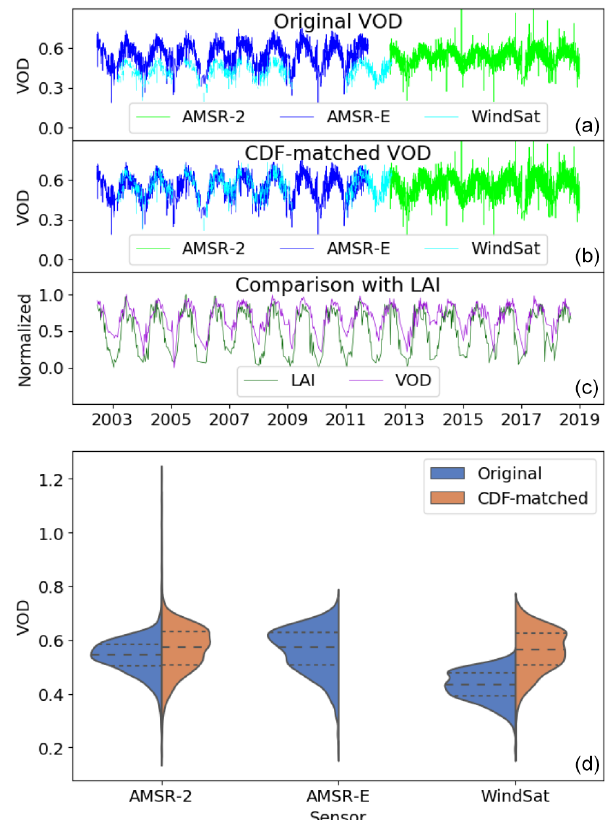
Figure 3. (a–c) Example X-band time series for a grid cell in Aus- tria (15.125 ◦ E, 48.125 ◦ N, mostly farmland with about 20% forest) at different processing steps. Time series of the original VOD data of all available sensors are shown in (a) , the CDF-matched series in (b) , and the final merged VOD (VODCA) together with MODIS LAI in (c) . In (c) VOD and LAI are both normalized, and VOD is downsampled by moving average to match the temporal 8d resolu- tion of LAI. (d) Violin plot showing the effect of CDF matching on the statistical distribution of